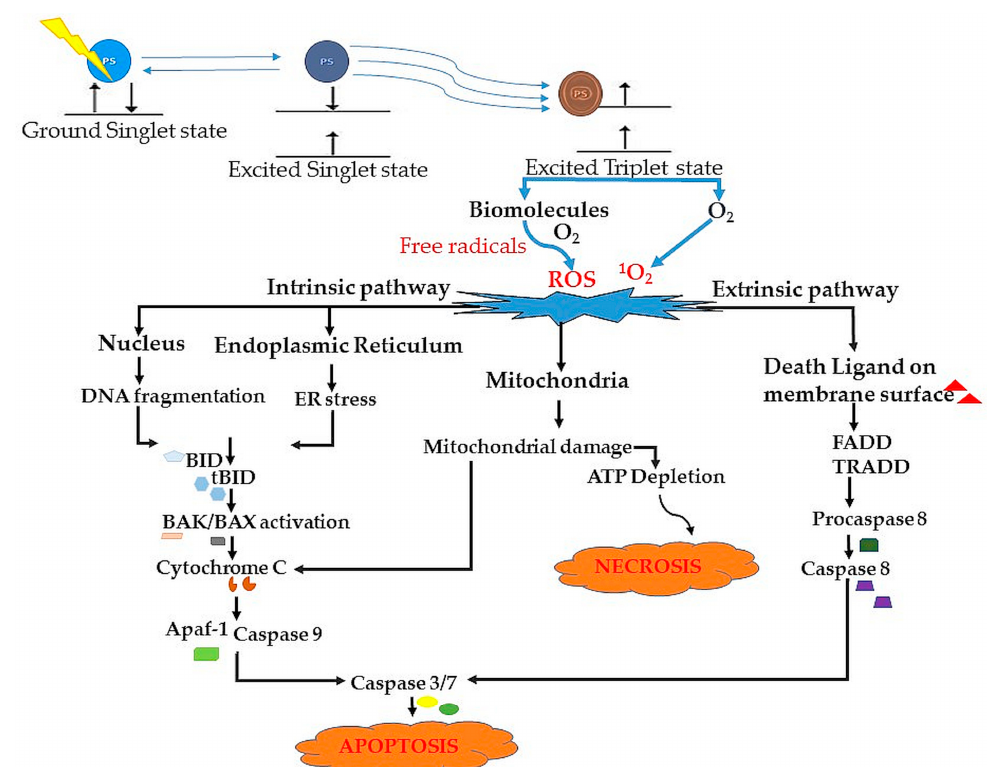
Figure 3. PDT activation of the apoptotic and necrotic pathways. During PDT, the PS becomes activated from its singlet ground state to its excited singlet state. With continued light irradiation the PS undergoes an intersystem, crossing to its excited triplet state. Two types of reactions can occur depending on the availability of free radicals and molecular oxygen. These include type I and type II reactions. In type I, photo-oxidation occurs with the use of free radicals, while in type II reactions it occurs with the use of molecular oxygen. The apoptotic pathway will take place via the intrinsic or extrinsic pathway. Intrinsic pathway results from DNA fragmentation and ER stress. Extrinsic pathway is activated by the death ligand on the membrane surface. Necrosis will occur due to ATP depletion.